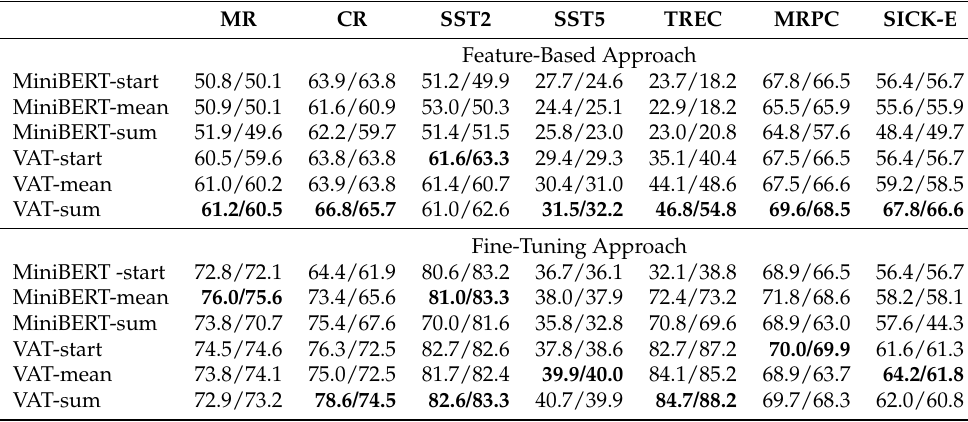
Table 5. Dev/test accuracies on the SentEval transfer classification tasks. A single dense layer with nonlinear activation and the Adam optimizer is used as the classification layer. Bold values indicate the best test result for each task in the feature-based and fine-tuning approach. MR